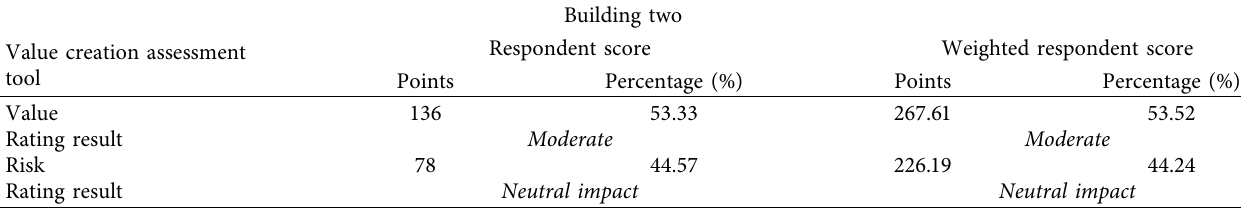
Table 7: Building 2 fnal rating results.